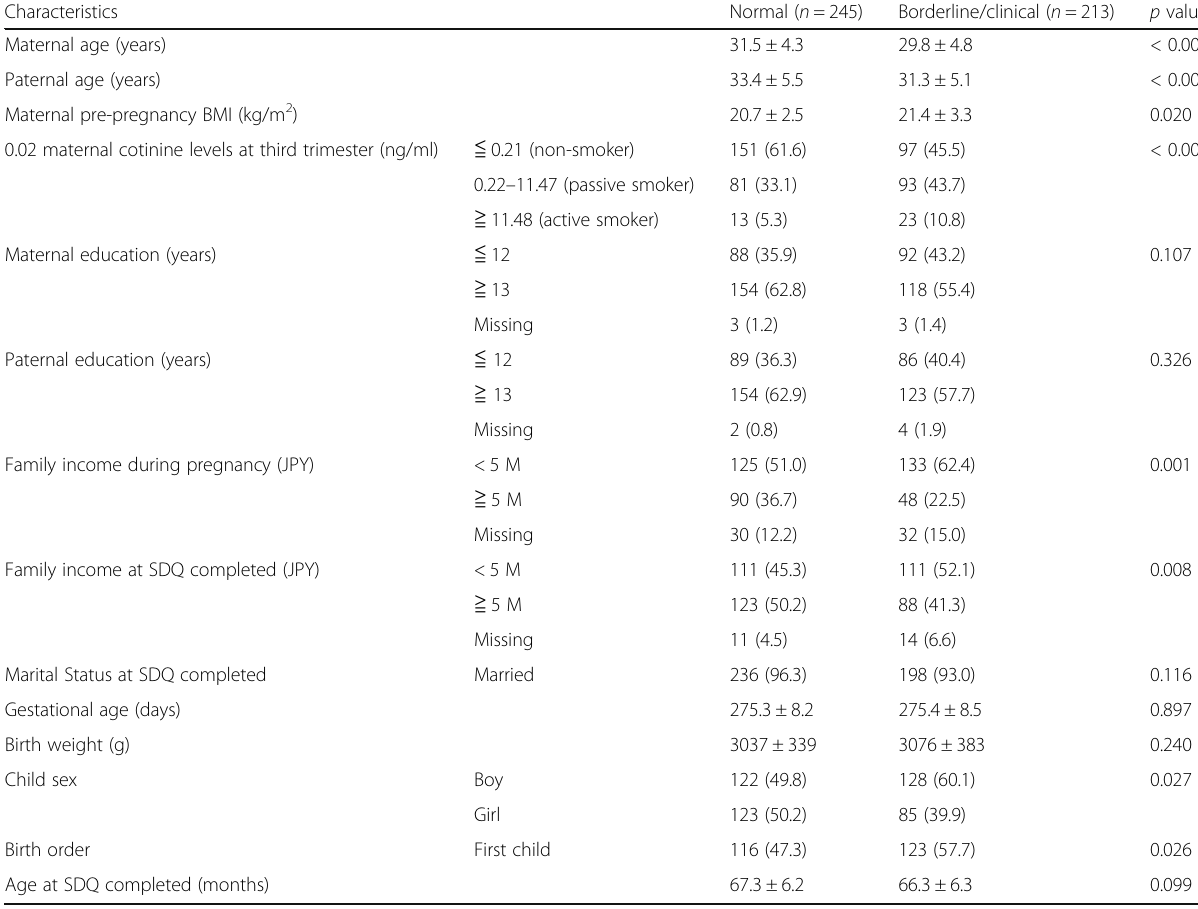
Table 1 Basic characteristics of parents and their children Characteristics